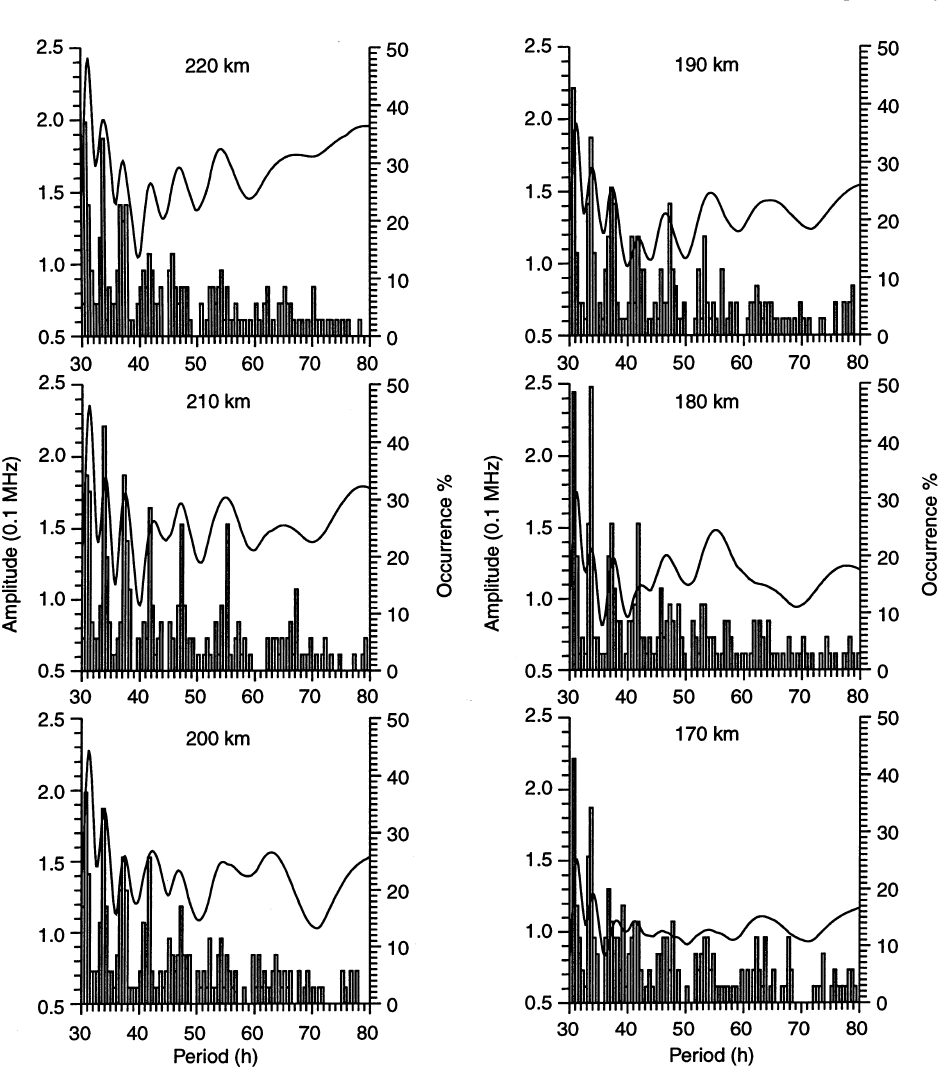
Fig. 2. Averaged amplitude spectra ( solid line ) and percent- age occurrence of periods ( his- tograms ) of ionospheric plasma frequency variations during 1995. The left y-axis represents the averaged amplitude and the right y-axis the percentage